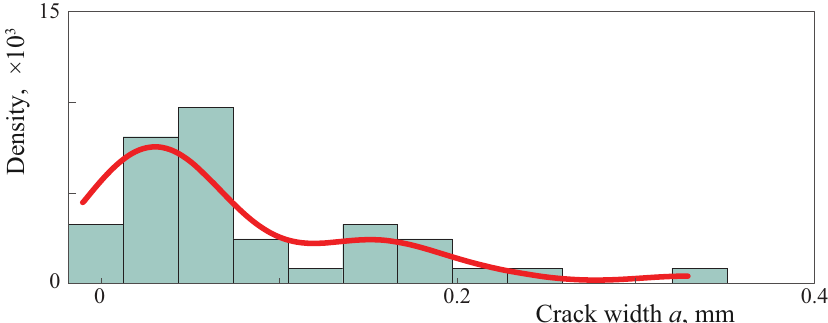
Figure 9. A typical example of histogram and the empirical density function of crack width distribu- tions a in bridged zones ( b = 20 mm, ∆ b = 10 mm, η = 10 − 4 ) for square-root